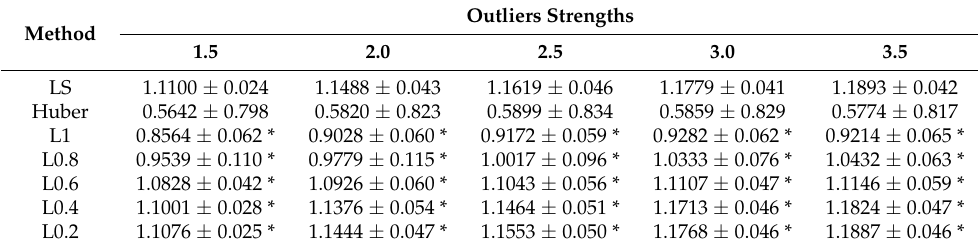
Table 7. Parameter estimation bias of the TISO system with different outlier